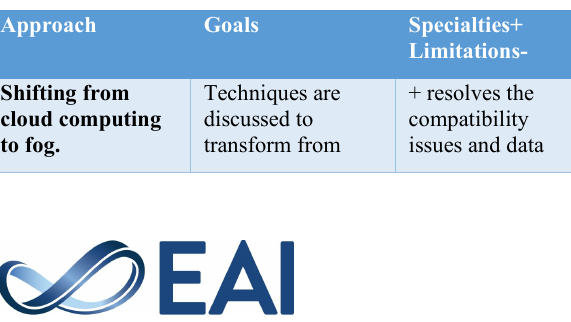
Table 1. Advantages and disadvantages of existing research work connected with the Cloud, Edge, and Fog